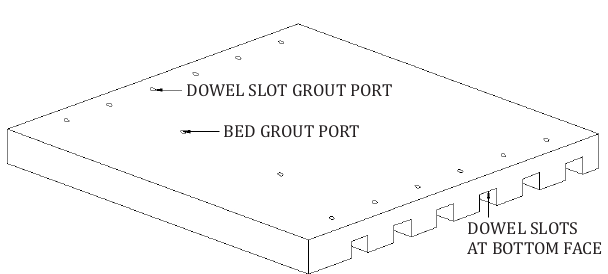
DOWEL SLOTS AT BOTTOM